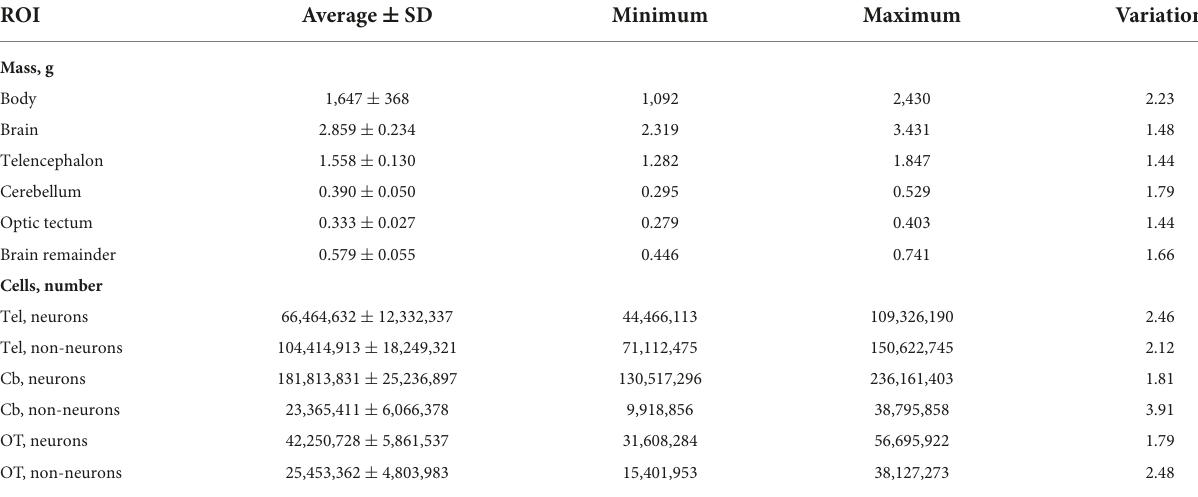
TABLE 1 Average and variation of the mass (g) and numbers of neurons and non-neuronal cells of the regions of interest (ROI)